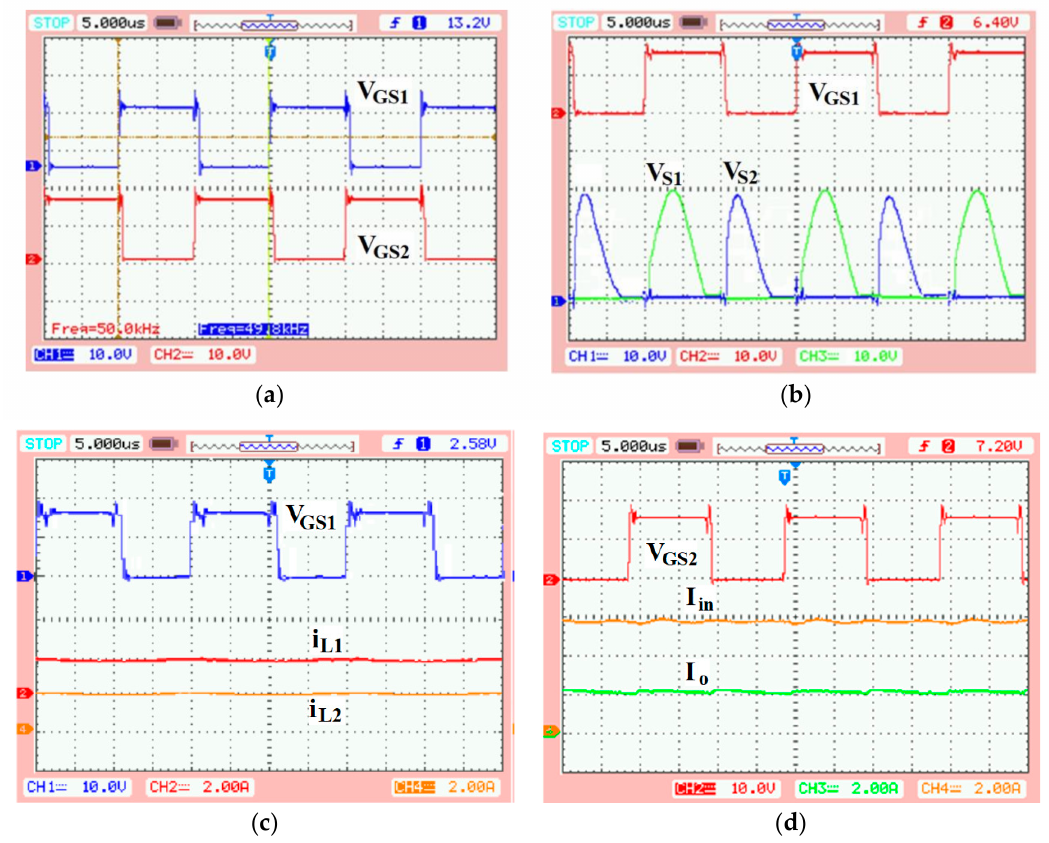
Figure 10. Measured waveforms for 1/3-type SDRSIC with I in = 6 A and R L = 3 Ω , ( a ) Ch1 (B): V GS1 ; Ch2 (R): V GS2 ; ( b ) Ch2 (R): V GS1 ; Ch1 (B): V S1 ; Ch3 (G): V S2 ; ( c ) Ch1 (top): V GS1 ; Ch2 (middle): i L1 ; Ch4 (bottom): i L2 ; ( d ) Ch2 (top): V GS2 ; Ch4 (middle): I in ; Ch3 (bottom): I o .